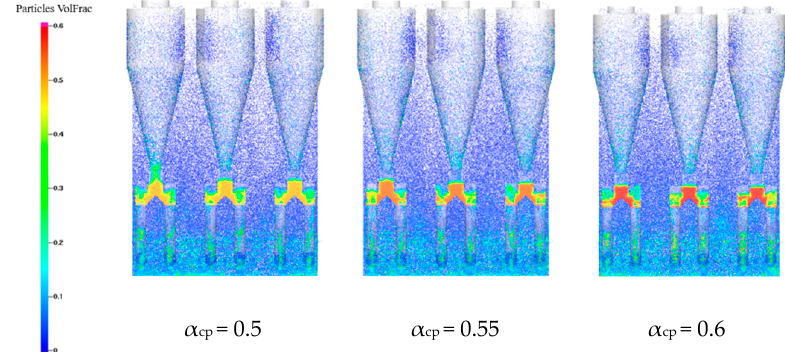
Figure 9. E ff ect of particle packing limit on gas-solid Figure 9. Effect of particle packing limit on gas-solid flow.